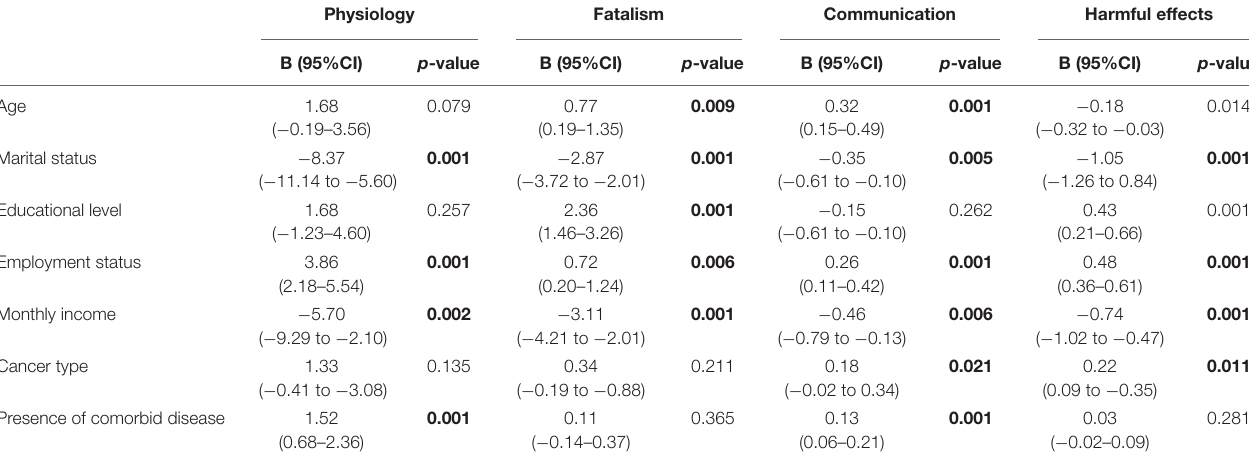
TABLE 6 | Predictors associated with attitudinal barriers to pain management of female cancer